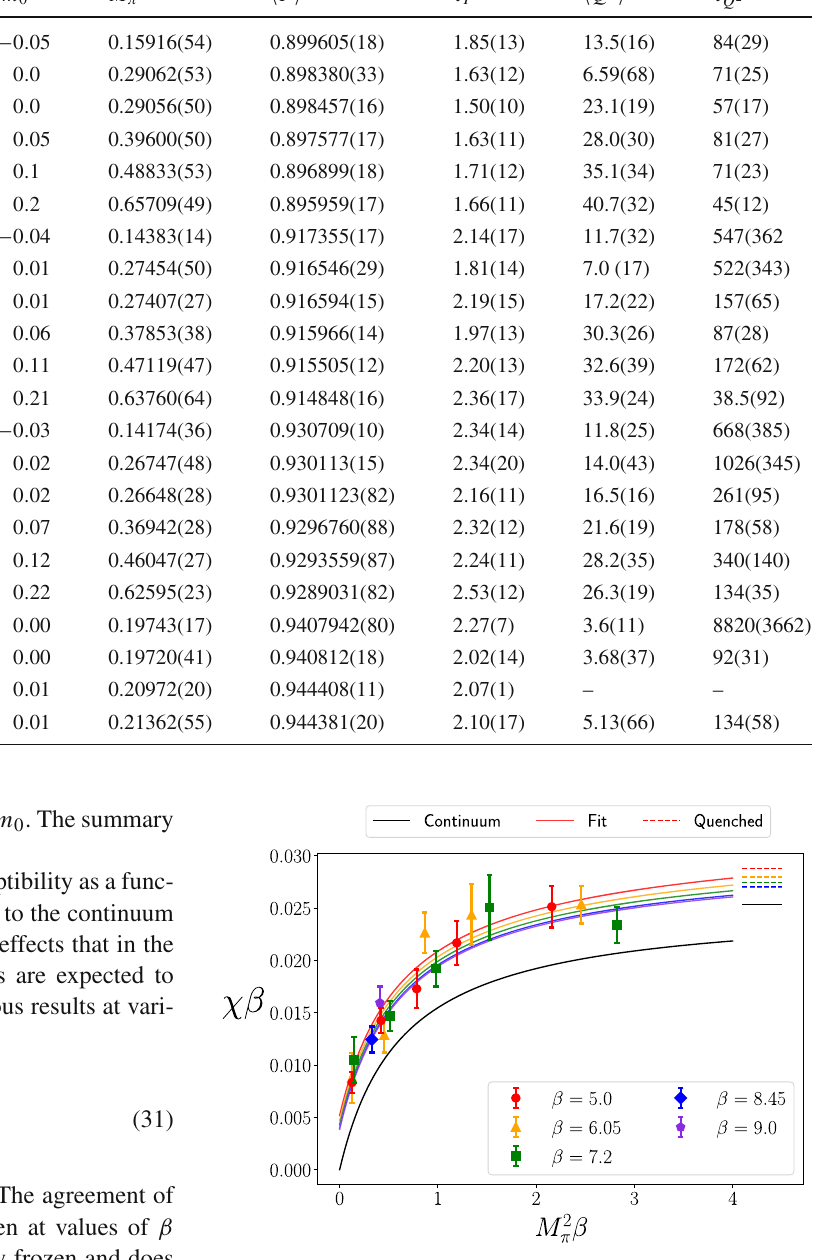
Fig. 9 Topological susceptibility in the N f = 2 theory as a function of the pion mass. The coloured solid lines are fits to the expression in Eq. (31) for five β ’s, while the black line is the continuum result. The horizontal dashed lines are the quenched expectations at the various β and the